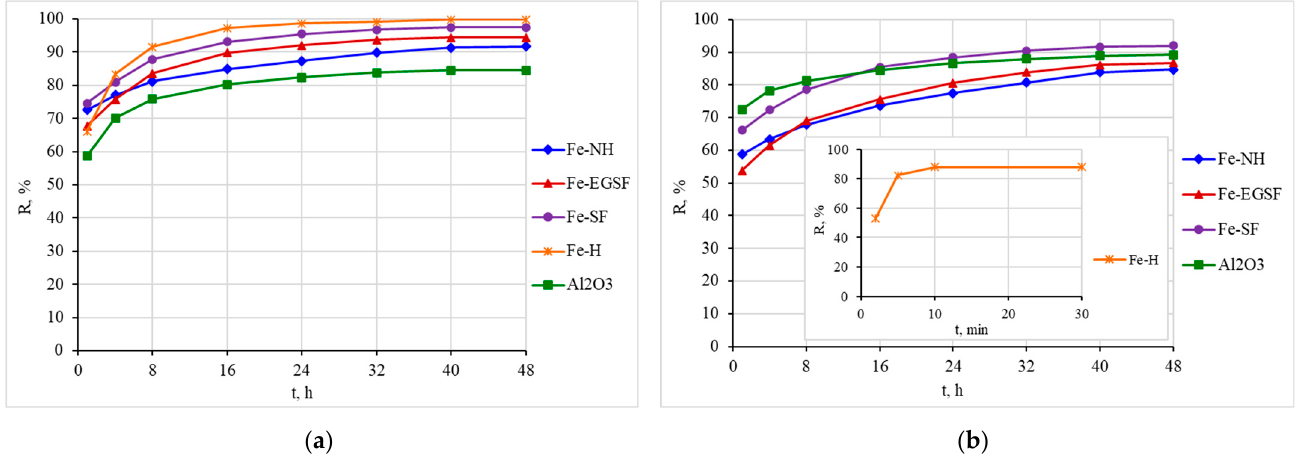
Figure 1. The dependence of the sorption efficiency on the time of sorption: ( a ) phosphorus; ( b ) beryllium. The established dependences of the recovery of phosphorus and beryllium were described using the following models of sorption kinetics (Table 3):